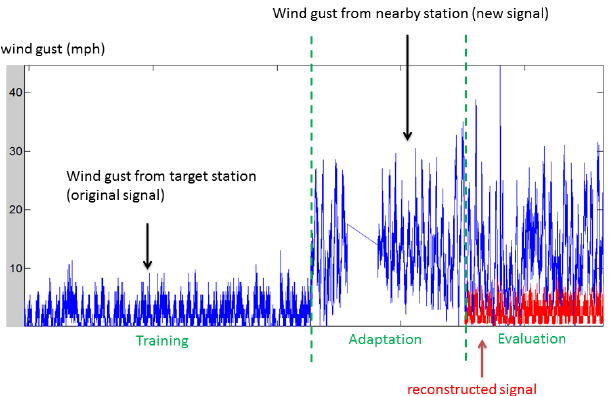
Figure 7. Visualization of the reconstructed wind gust by ASC. The blue curve represents observed sensor values and the red curve represents reconstructed sensor